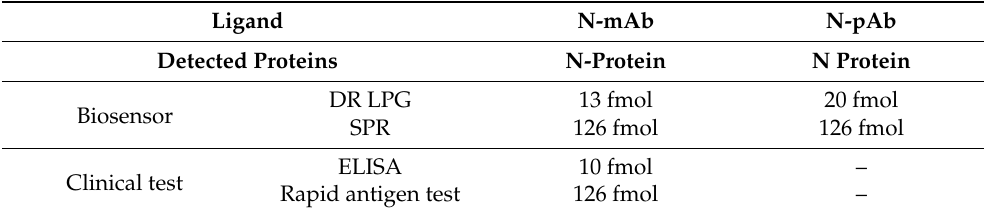
Figure 10. Limit of Detection (LOD) determination of a rapid antigen test. Table 4. Comparison of established limits of detection for DR LPG, SPR and clinical